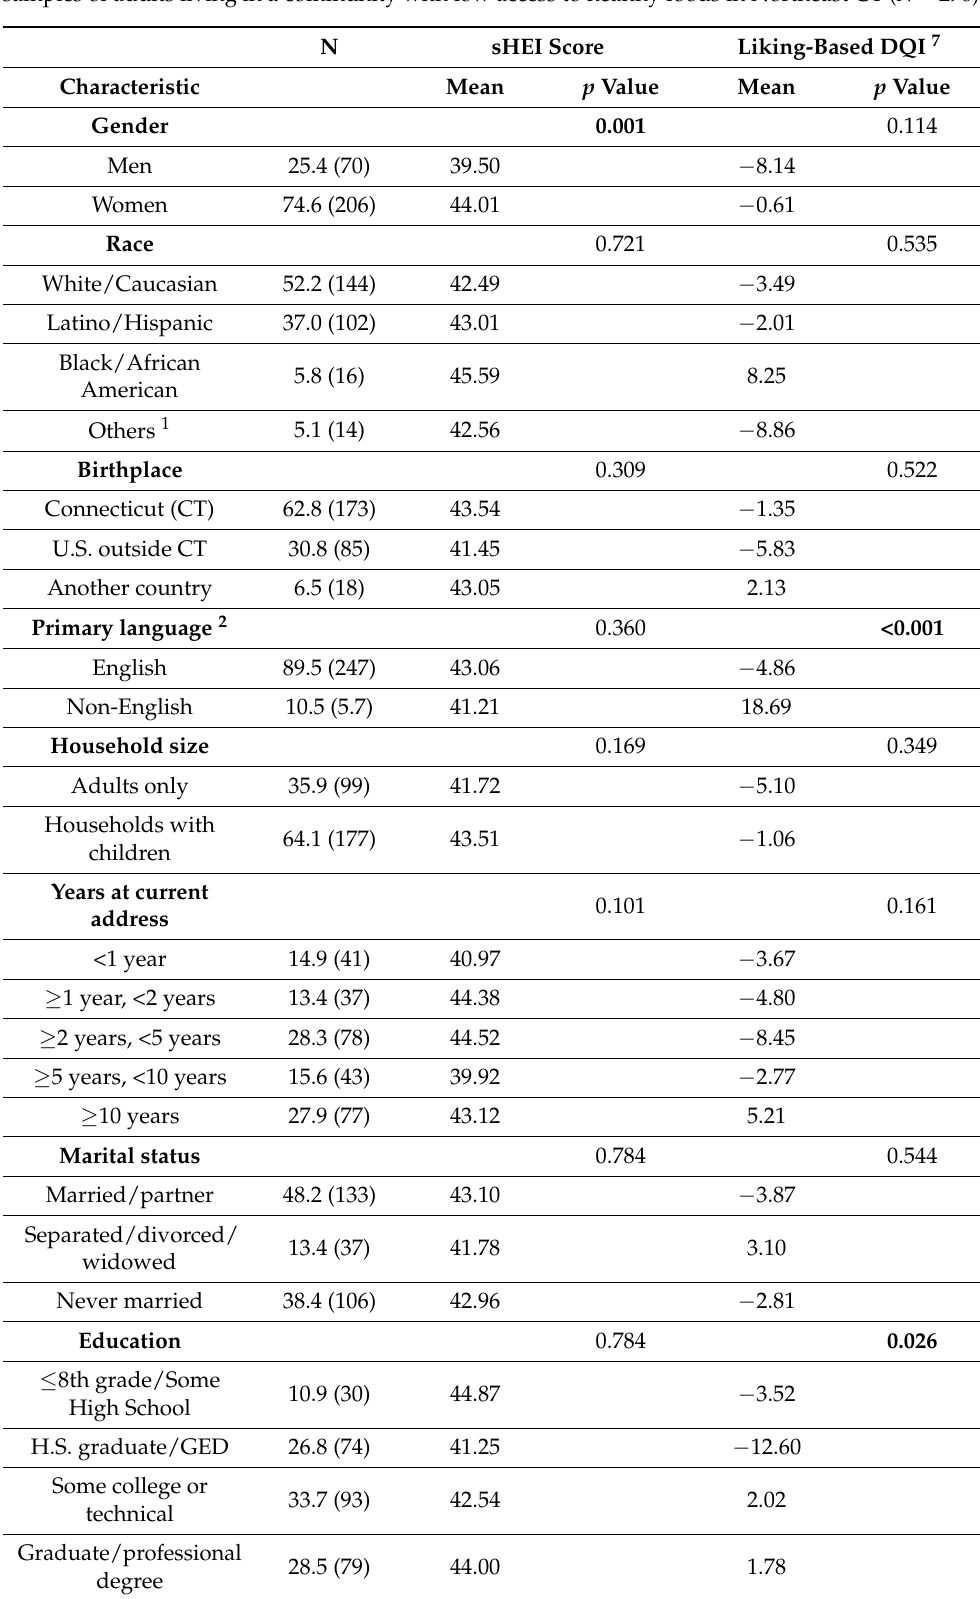
Table 4. Unadjusted measures of diet quality by sociodemographic and health characteristics among samples of adults living in a community with low access to healthy foods in Northeast CT ( N = 276). N sHEI Score Liking-Based DQI 7 Characteristic